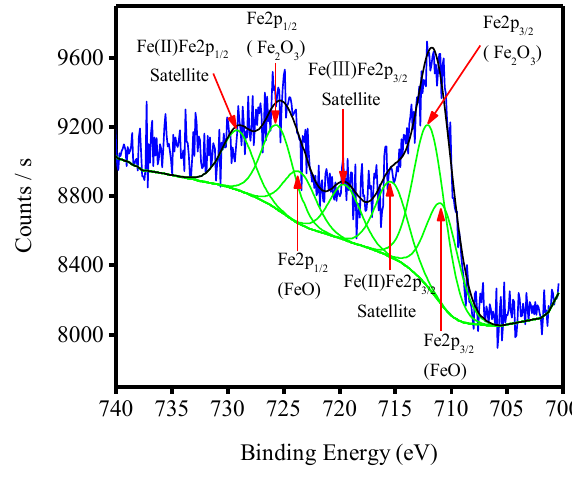
Figure 2. XPS spectra in the Fe2p region of EBFS.